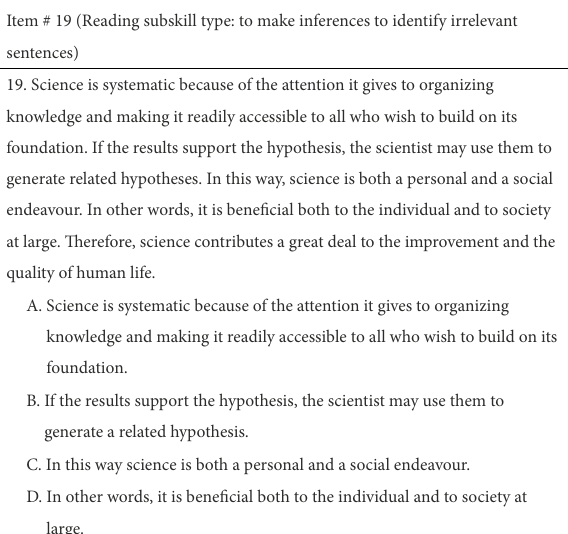
TABLE 4 Sample item from the reading comprehension